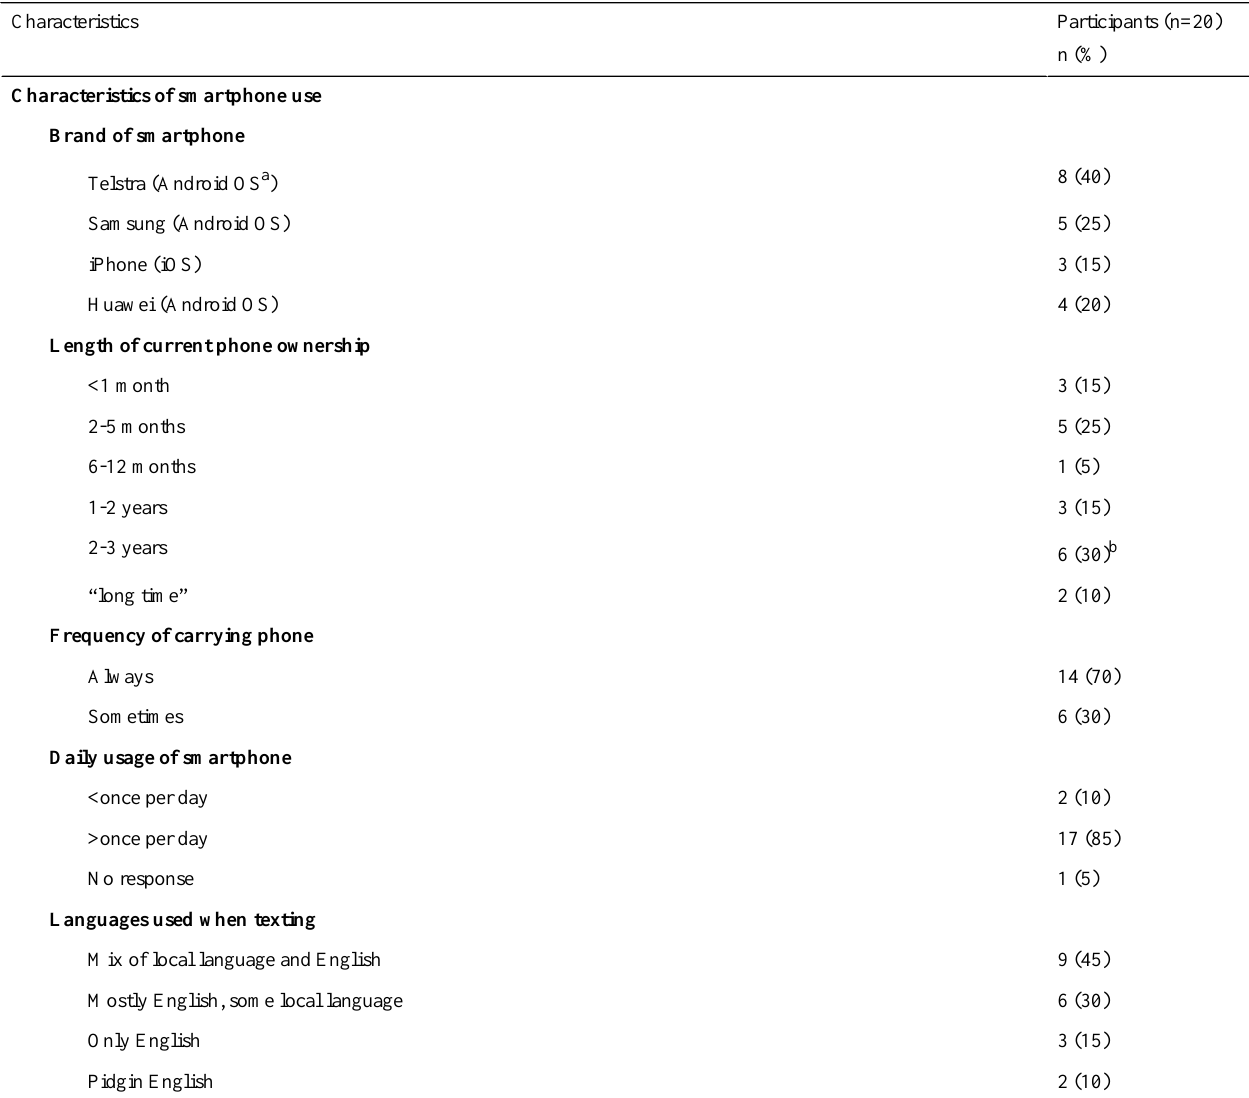
Table 2. Characteristics of smartphone and app